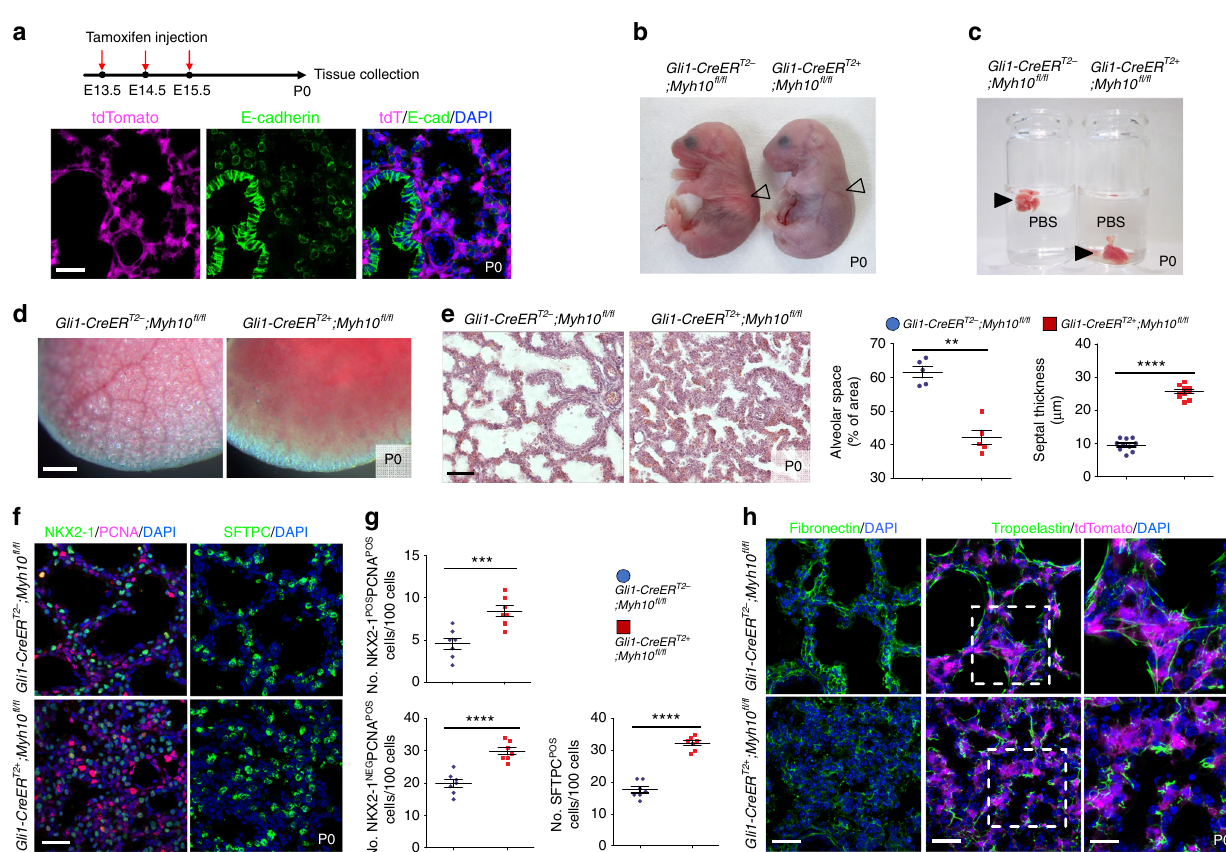
Fig. 5 Mesenchyme-speci fi c Myh10 deletion disrupts lung development. a Diagram indicating time points of tamoxifen injections and tissue collection. Immunostaining for E-cadherin in Gli1-Cre ERT2 ;ROSA26 tdTomato P0 lungs. b Gross morphology of wild-type ( n = 10) and Gli1-Myh10 cKO ( n = 8) P0 mice. Arrowheads point to in fl ated (left) and non-in fl ated lungs (right). c Floating assay for wild-type ( n = 10) and Gli1-Myh10 cKO ( n = 8) P0 lungs. d Representative pictures of distal lung from wild-type ( n = 10) and Gli1-Myh10 cKO ( n = 8) P0 mice. e H&E staining and morphometric analysis of alveolar space and septal thickness in wild-type ( n = 10) and Gli1-Myh10 cKO ( n = 8) lungs at P0. f Immunostaining for NKX2-1, PCNA, and SFTPC in wild-type ( n = 10) and Gli1-Myh10 cKO ( n = 8) P0 lungs. g Quanti fi cation of cell proliferation and differentiation in wild-type and Gli1-Myh10 cKO P0 lungs. h Immunostaining for fi bronectin, tropoelastin, and tdTomato in wild-type ( n = 10) and Gli1-Myh10 cKO ( n = 8) P0 lungs. Error bars are means± s.e.m. ** P < 0.01, *** P < 0.001, **** P < 0.0001, two-tailed Student ’ s t -test. Scale bars: 500 μ m ( d ), 50 μ m ( e ), 30 μ m ( a , f , h (left, middle)), 15 μ m ( h